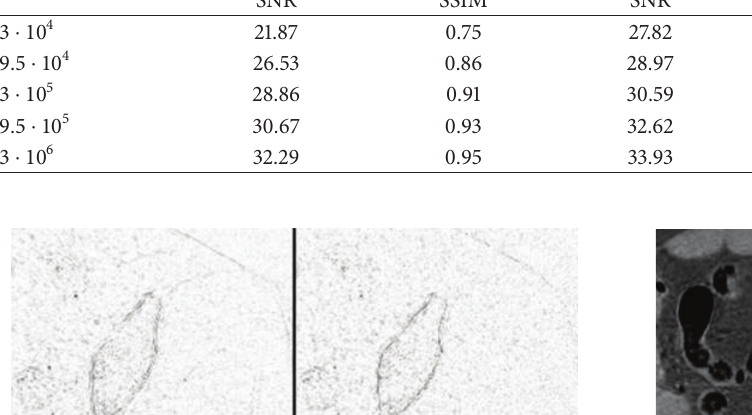
Table 2: Quantitative measures corresponding to the image array in Figure 15. The SNR is measured in HU window of [−220,350] . Noise level 𝜆 0